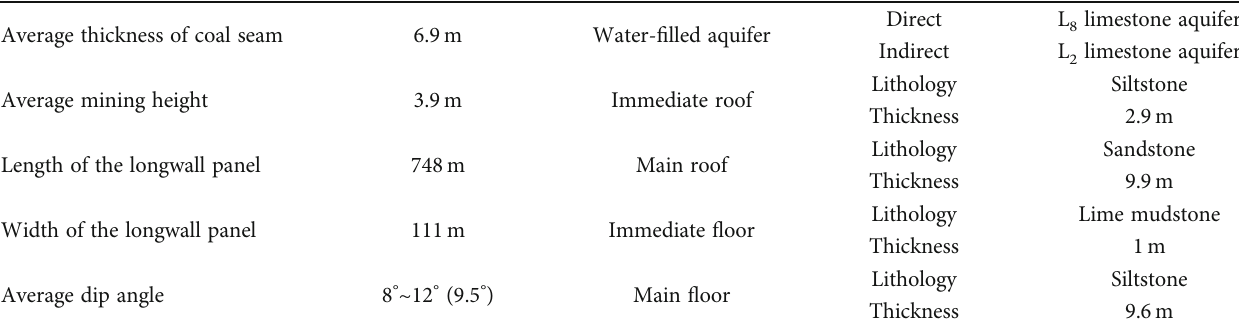
Figure 2: Layout of 14141 longwall panel. Table 1: Basic parameters of the 14141 longwall